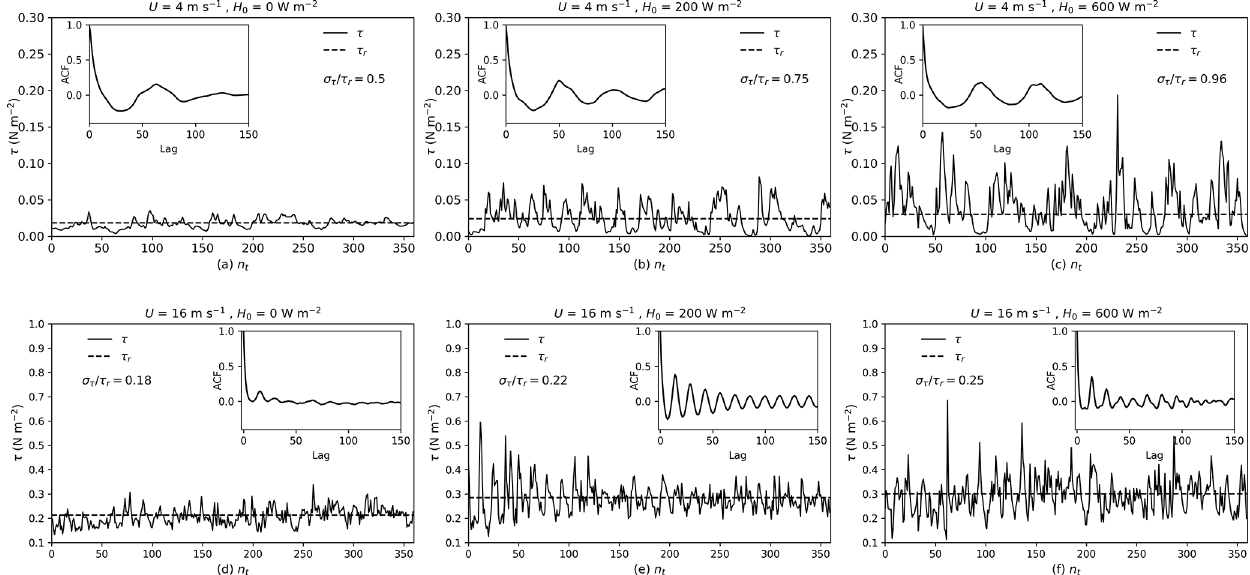
Figure 1. Time evolution of surface shear stress τ with different H 0 values and z 0 = 0 . 153mm at the grid point n x = 198 and n y = 41 (a–c) for U = 4ms − 1 and (d–f) for U = 16ms − 1 ; the inset plots are the autocorrelation functions of τ